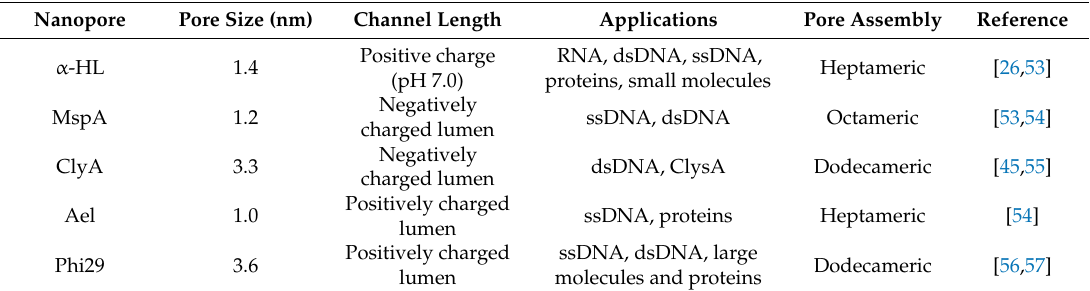
Table 1. Summary of the characteristics of biological nanopores including pore size, pore assembly, and their area of